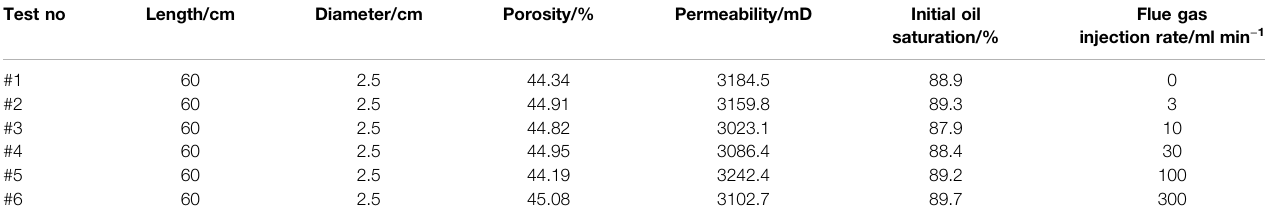
TABLE 1 | Sandpack parameters for the CSS experiment.